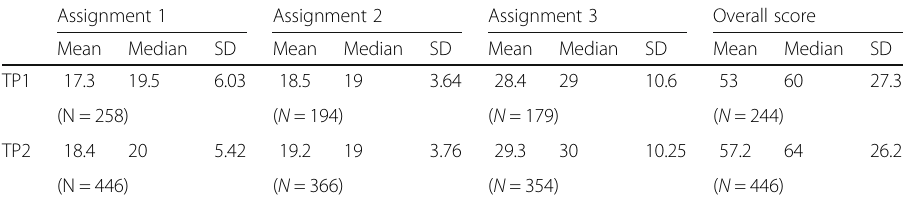
Table 1 Mean and median scores and SDs for the 3 assessments and units overall for teaching period 1 and